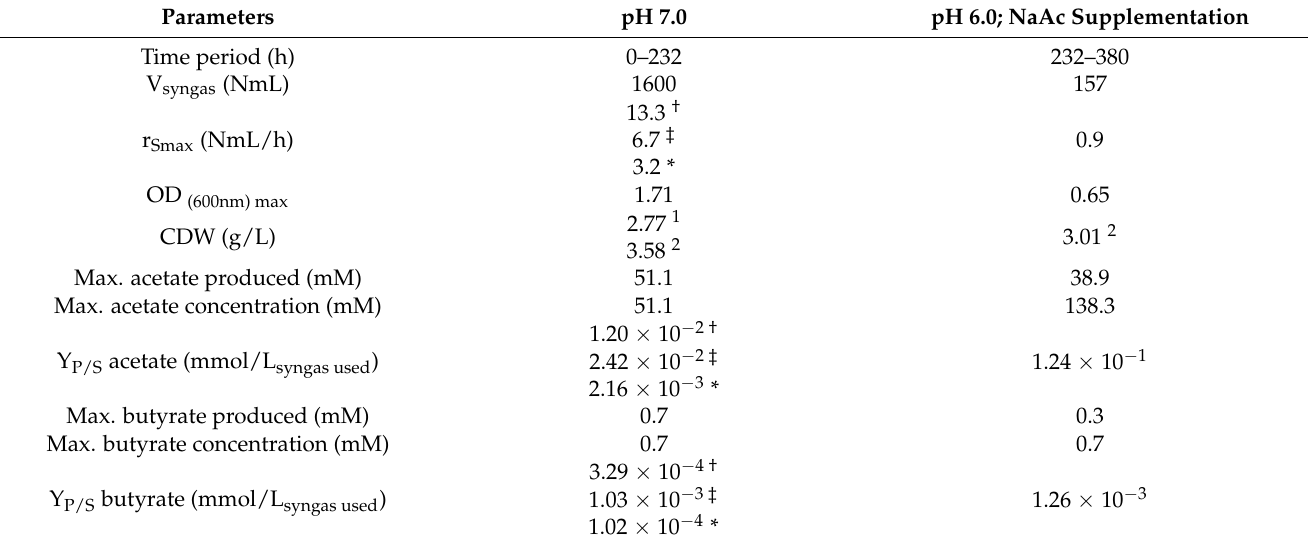
Figure 3. Time course representation of B. methylotrophicum growth with on-demand Syngas B supply at pH 7.0 and 6.0. The continuous line represents the volume of Syngas B infeed, and the colored vertical bars represent ( a ) cell dry weight (CDW), ( b ) acetate concentration and ( c ) butyrate concentration. The vertical dashed lines represent the time points where the culture medium was partially replaced by new nutrient stock solution during pH 7.0 or when the pH set-point was changed to 6.0 and the culture medium was supplemented with sodium acetate. Table 4. Syngas feed, cell growth, yields and productivities achieved in the bioconversion of Syngas B by B. methylotrophicum in four sequential batches under on-demand gas feed, at pH 7.0 and pH